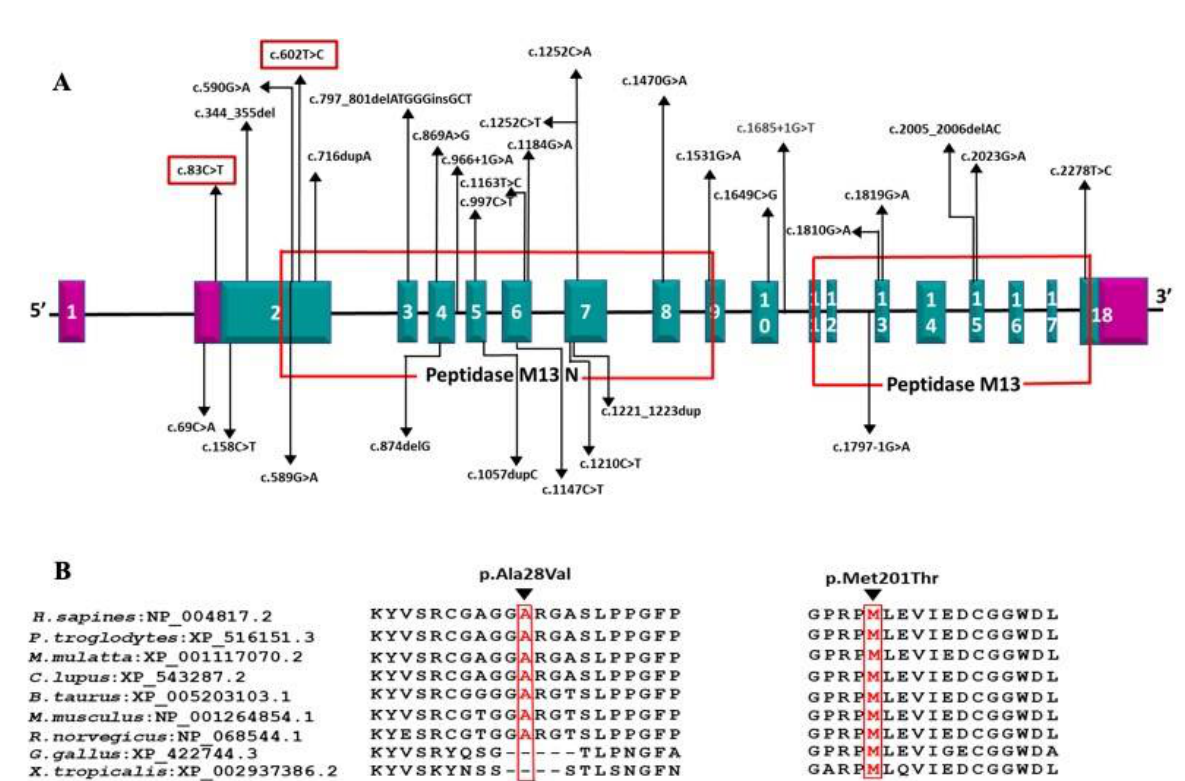
Figure 4. ( A ) Schematic representation of the variations identified in the ECEL1 gene with corresponding exons and protein domains. The 18 exons of ECEL1 (NM_004826.4) are represented as boxes with respective exon numbers. Regions of exons coding for UTRs are marked in violet color at the ends. The protein domains are according to the Uniprot database. The novel variant found in our is study is marked in the box. The size of exons /introns is not represented at scale; ( B ) amino acid conservation at positions 28 and 201 across species.